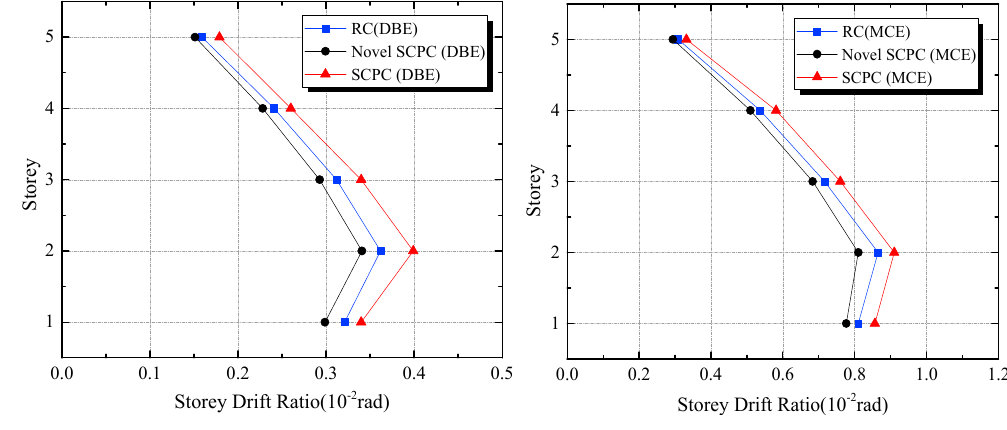
( a ) Maximum inter-story drift ratios θ max of the three frames for each near-fault ground motion.